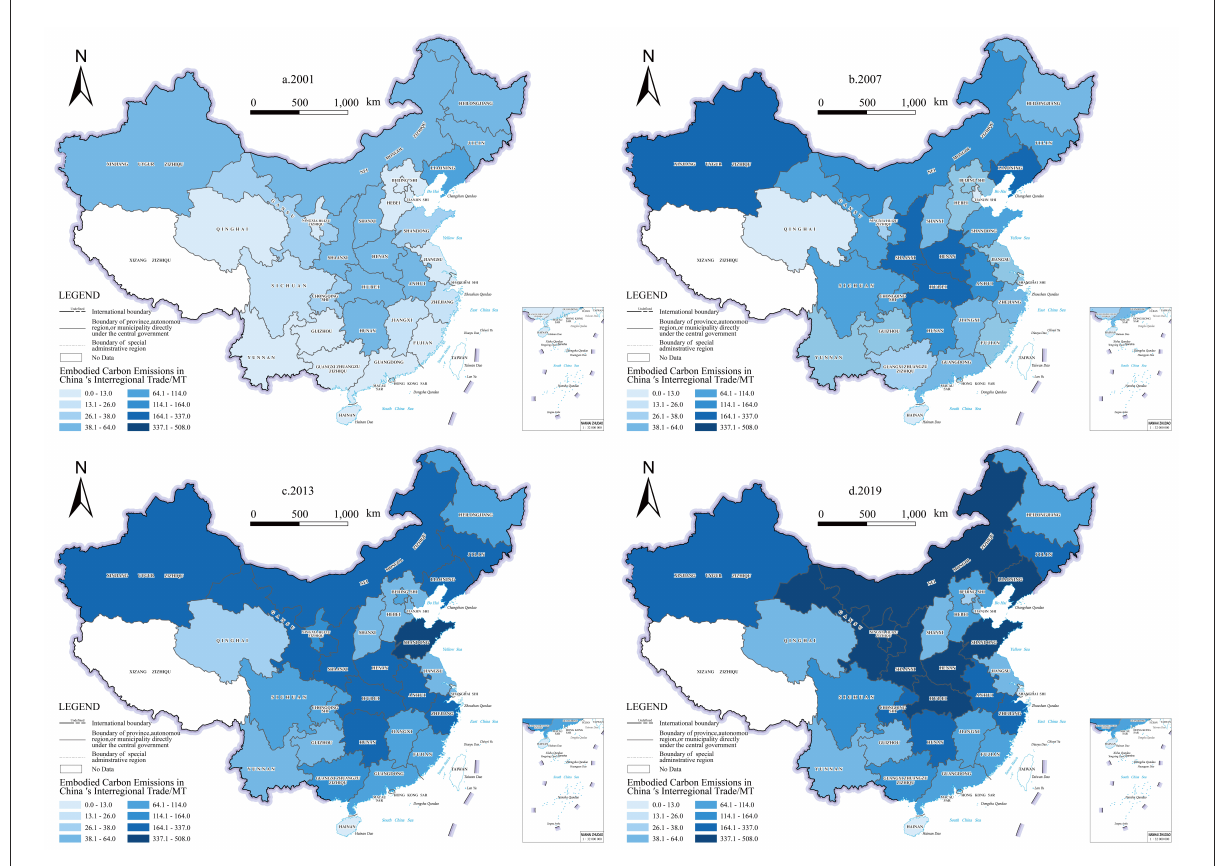
FIGURE1 Spatial and temporal patterns of embodied carbon emissions in inter-regional